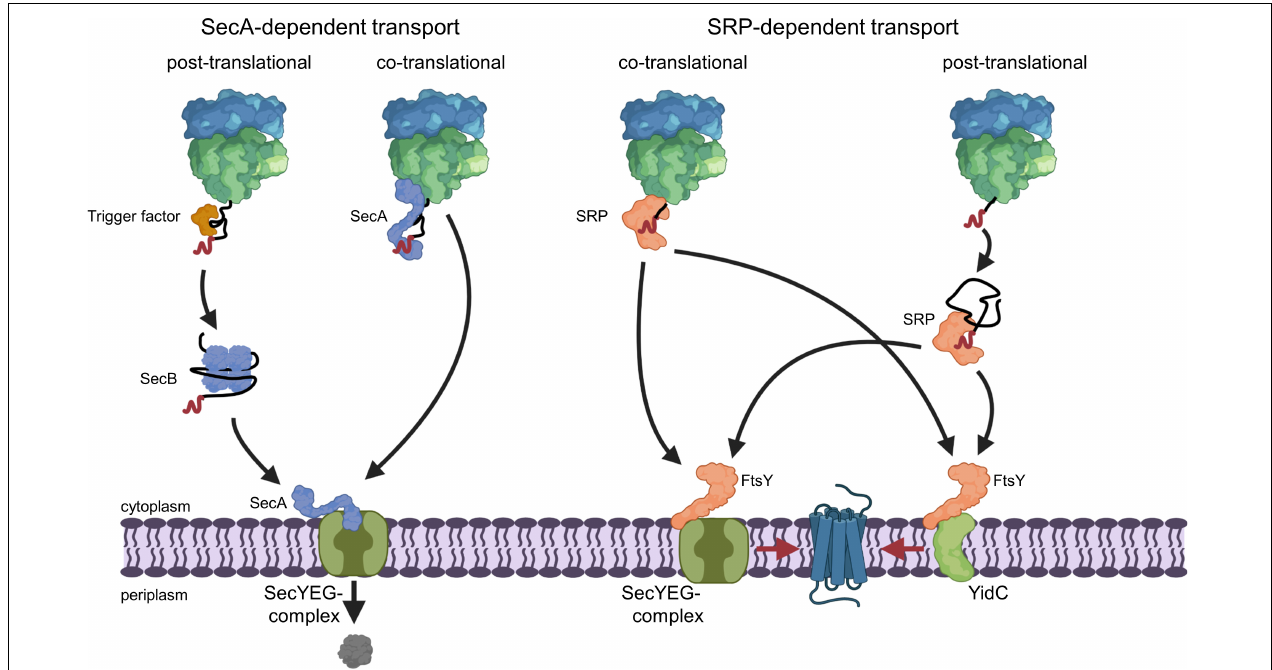
FIGURE 2 | SecA- and SRP-dependent protein targeting in bacteria. The SecA- and SRP-dependent protein targeting pathways constitute the two main protein targeting pathways in bacteria and both can operate in a co- or post-translational mode. However, post-translational targeting of secretory proteins by SecA and co-translational targeting of membrane proteins by SRP are the preferred modes. Substrates of the post-translational SecA pathway are kept in a translocation competent state by chaperones, like the ribosome-bound TF or the cytosolic SecB. SecA serves as receptor for signal sequences (shown in red) of secretory proteins and is bound to the SecYEG translocon, which serves as main protein transport channel in bacteria. Repetitive ATP hydrolysis cycles by SecA allows for the translocation of the polypeptide across the SecY channel. SecA can also associate with the ribosome and target potential substrates co-translationally to the SecYEG translocon. The subsequent ATP-dependent translocation likely occurs then post-translationally, i.e., after the substrate is released from the ribosome. SRP binds with high affinity to translating ribosomes and traps the signal anchor sequence of a membrane protein when it emerges from the ribosomal peptide tunnel. SRP then delivers the translating ribosome (ribosome-associated nascent chain, RNC) to the SRP receptor FtsY. FtsY serves as SecYEG-bound receptor for nascent membrane proteins and engages similar binding sites as SecA on the SecYEG translocon. After SRP-FtsY contact, the translating ribosome docks onto the SecYEG translocon and ongoing translation inserts the protein into the lipid phase. FtsY can also associate with the YidC insertase and SRP can deliver less complex membrane proteins co-translationally to the YidC insertase for insertion. Small membrane proteins ( < 50 amino acids) and likely tail-anchored membrane proteins are post-translationally bound by SRP and targeted to SecYEG or YidC only after they have been released from the ribosome. This post-translational insertion by SRP is likely initiated by a so far largely uncharacterized mRNA-targeting step (Steinberg et al., 2020), which is not depicted in this